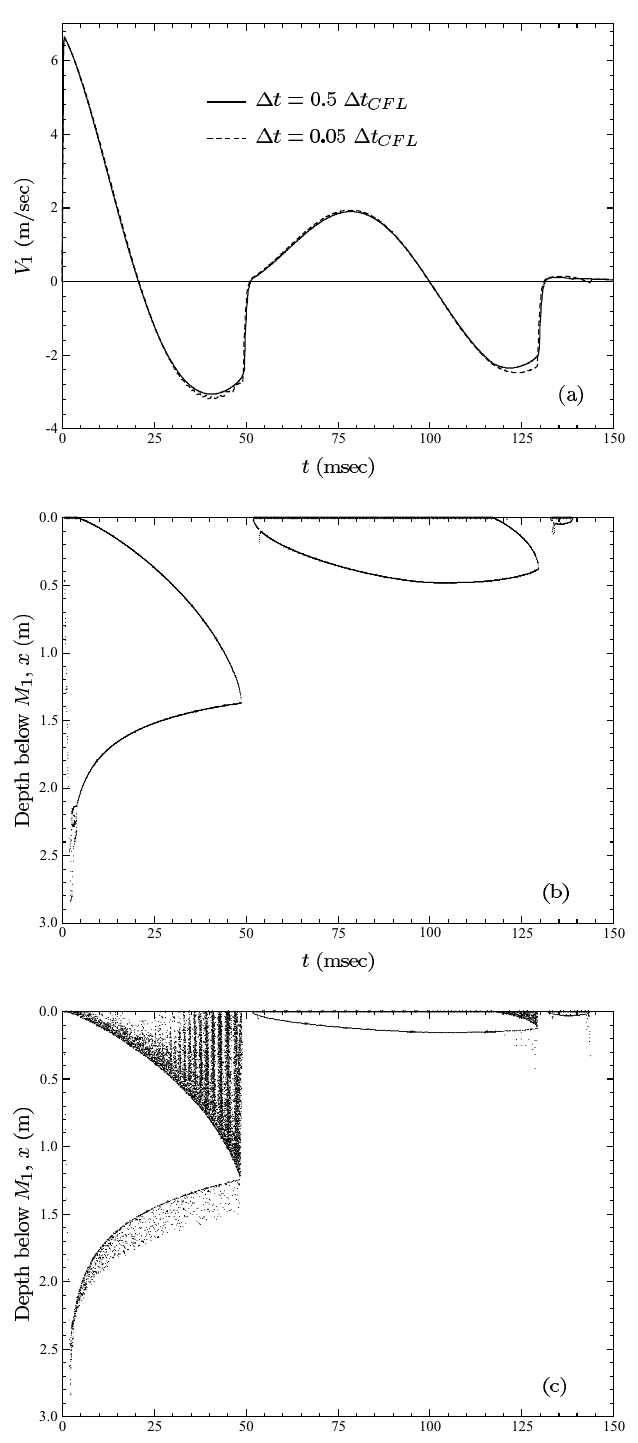
Fig. 12. (a) V 1 -response histories for M 2 /M 1 = 5 calculated with two ∆ t values. Fluid-change-of-phase plot for (b) ∆ t = 0 . 5∆ t CFL and (c) ∆ t = 0 . 05∆ t CFL